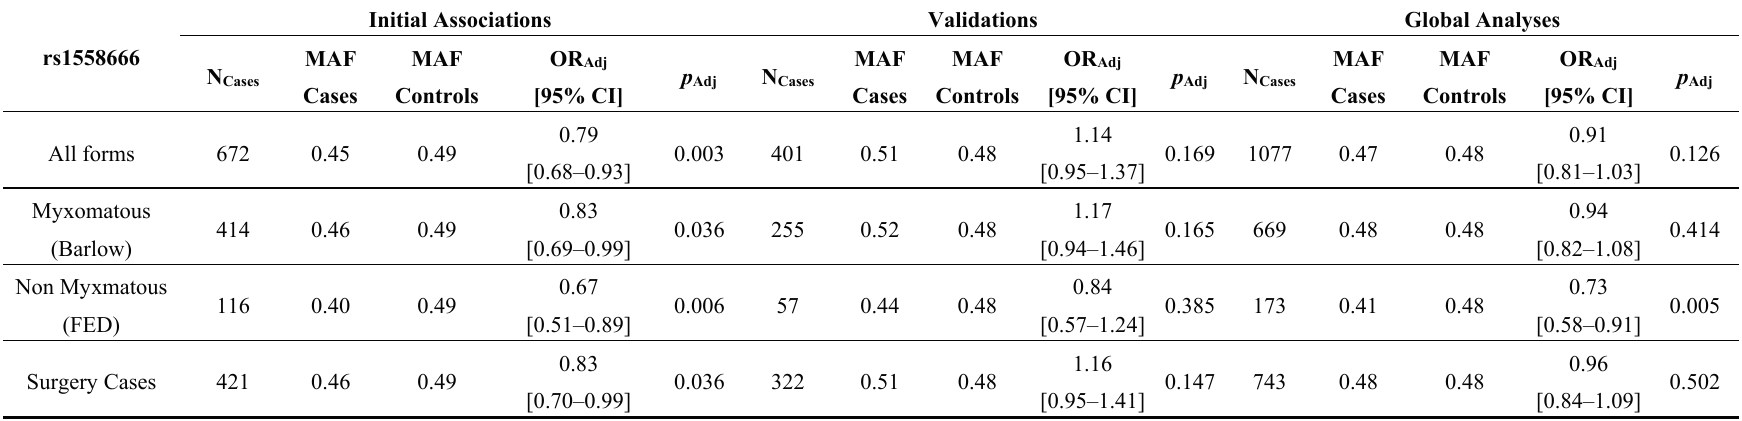
Table 4. Association of rs1558666 with mitral valve prolapse in the initial association studies, the validation and the global analyses.